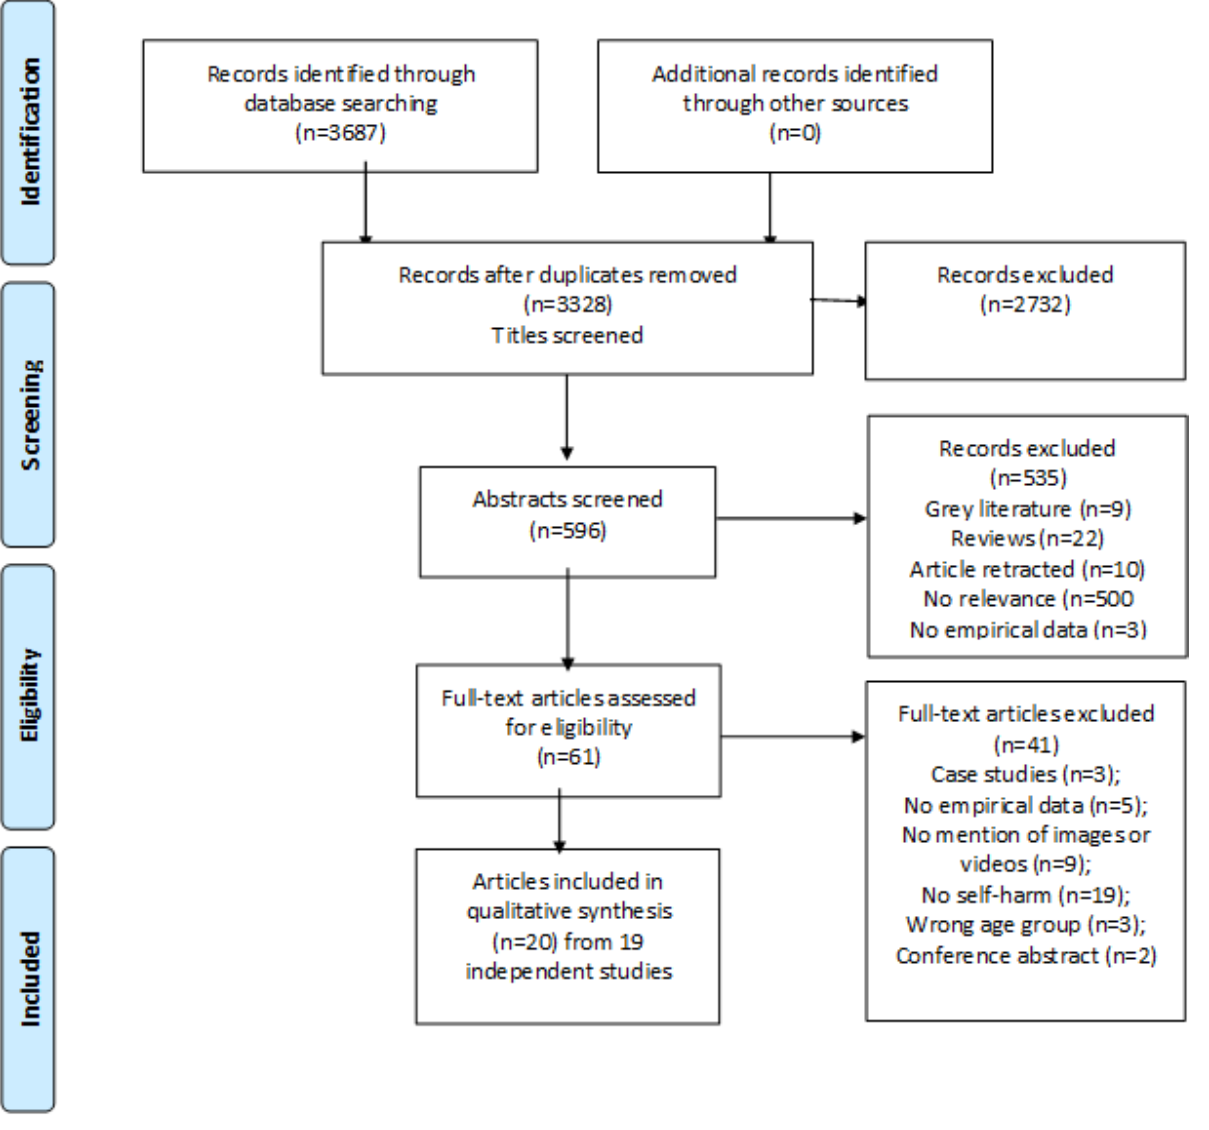
Figure 1. Results of the search strategy and screening